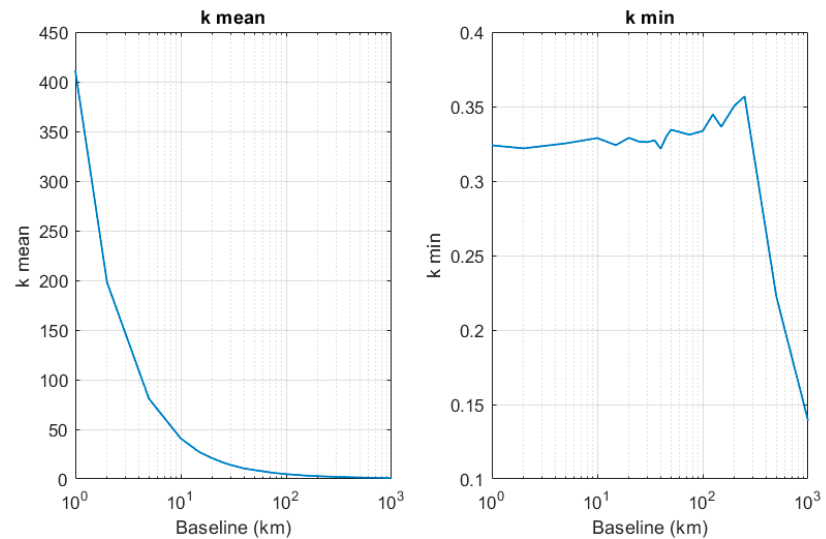
Figure 4. Trend of the two coefficients k AVERAGE and k MIN versus baseline.